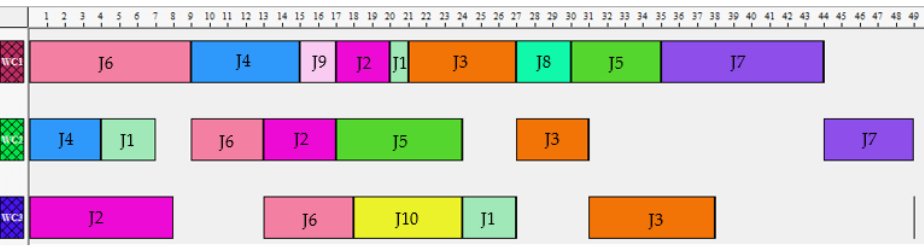
Figure 8. Gantt chart about the best solution found for scenario 2 (about problem instance 27).